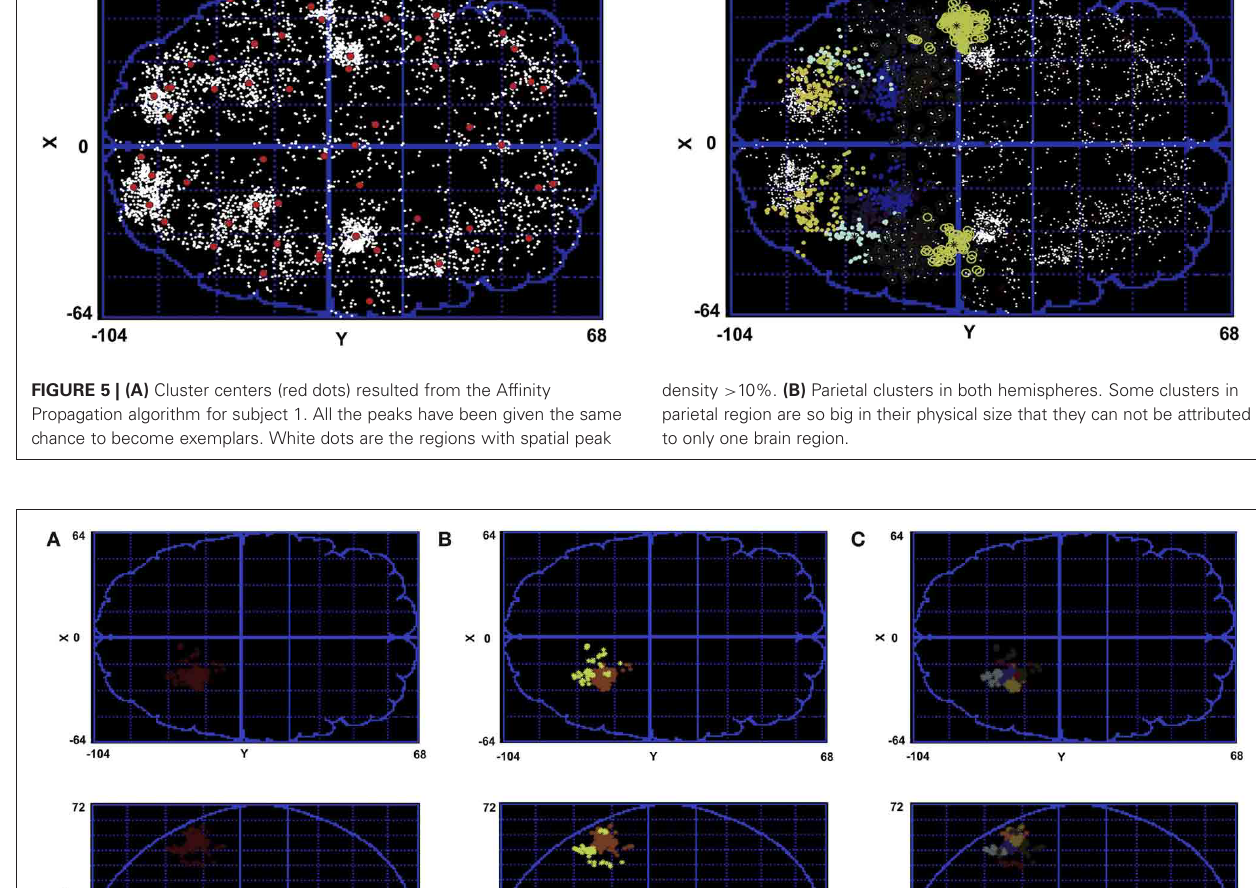
FIGURE 6 | An exampleofthe proposedmethod.(A) A clusterin parietalarea resultedfrom affinitypropagationalgorithm(radius:22mm). (B) Theeffectof cutting the cluster tree that leads to two clusters (maximum radius: 11mm). (C) The effect of cutting the cluster tree that leads to seven clusters (maximum radius: